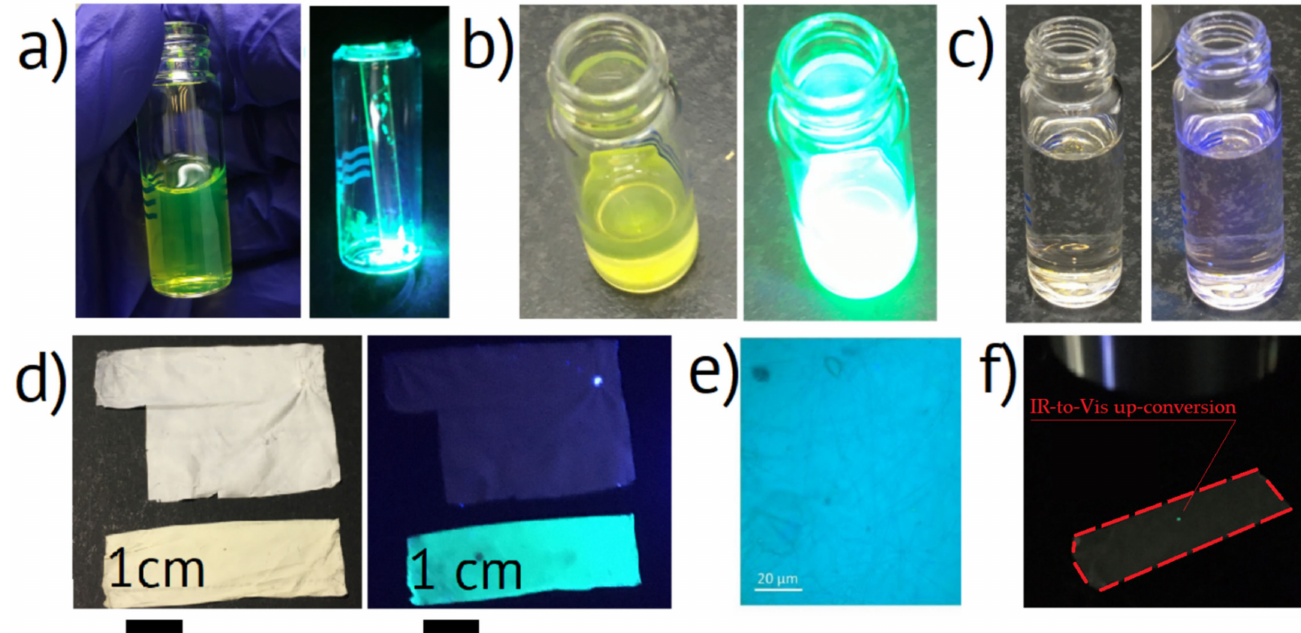
Figure 1. Photographs of ( a ) (left) as-synthesized CsPbBr 3 NPs transferred to toluene and (right) dry CsPbBr 3 NPs under UV lighting, ( b ) CsPbBr 3 NPs in BA under (left) fluorescent and (right) UV lighting, ( c ) CsPbBr 3 NPs in 1:1 BA/DMF solution under (left) fluorescent and (right) UV lighting, ( d ) nonwoven mats (up) without and (down) with recrystallized CsPbBr 3 NPs (left) in the daylight and (right) under UV lighting, ( e ) PL image of nonwoven mats, ( f ) IR to visible light up-conversion by CsPbBr 3 NPs in nonwoven mat, dash line marks the studied